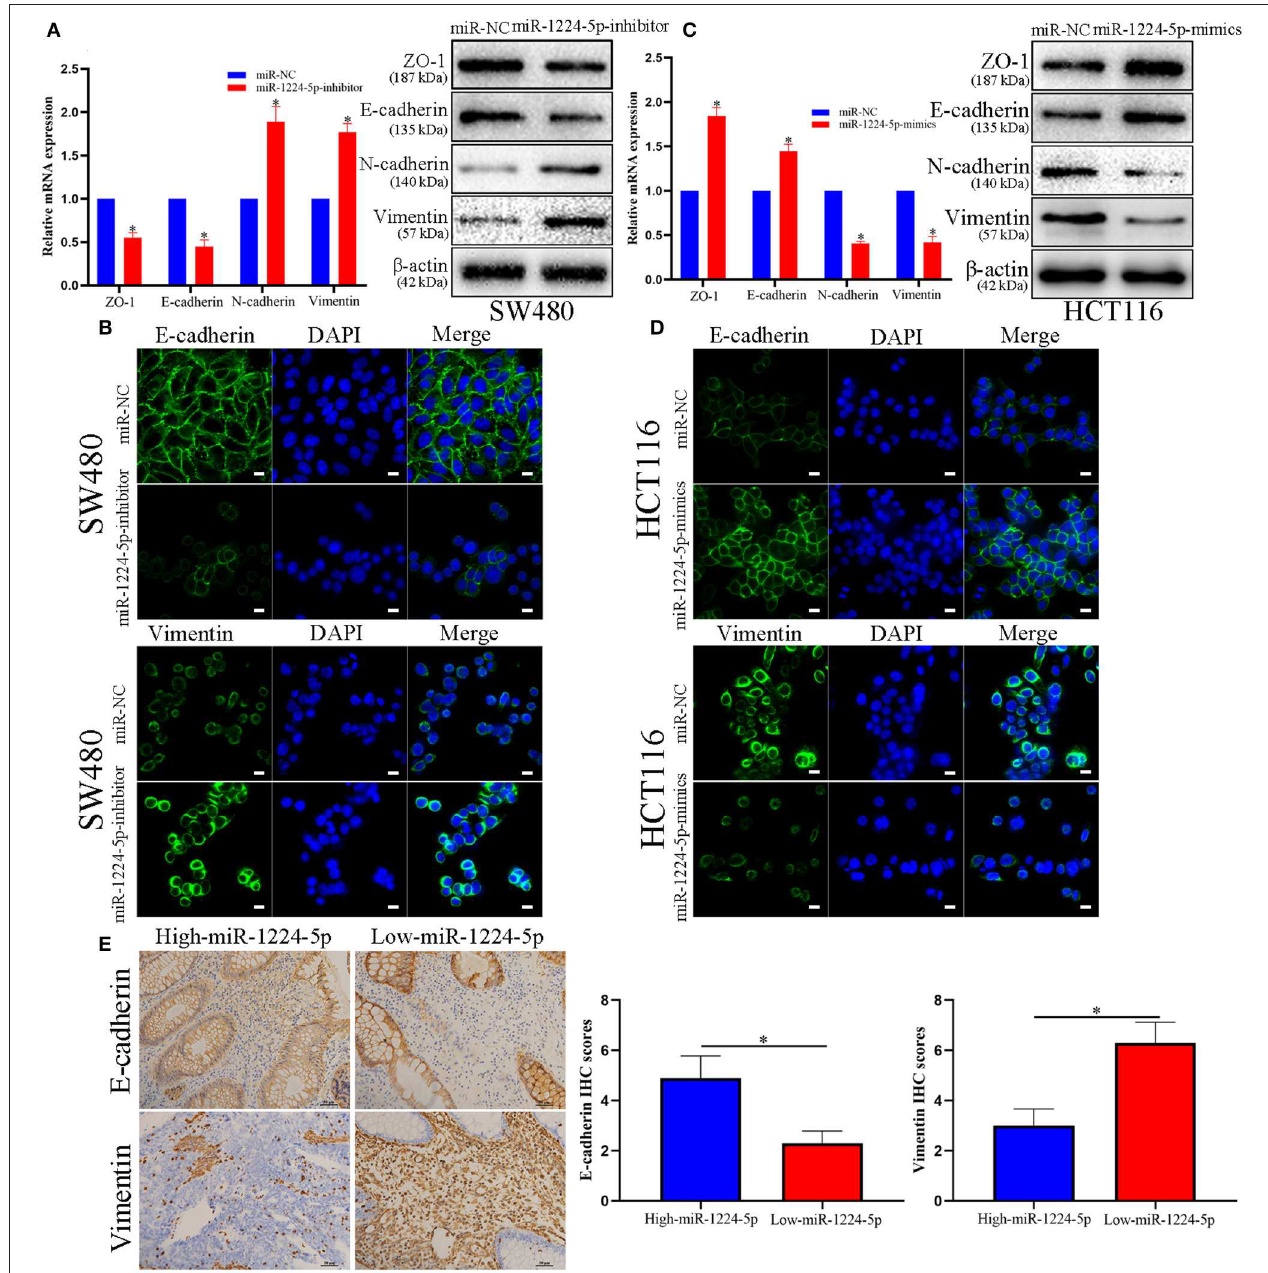
FIGURE 3 | miR-1224-5p inhibits the EMT process of CRC cells. (A) Western blot analysis of tight junction protein ZO-1, epithelial marker E-cadherin, and mesenchymal markers N-cadherin and Vimentin after miR-1224-5p knockdown in SW480 cells. (B) IF staining of E-cadherin and Vimentin after miR-1224-5p knockdown in SW480 cells, scale bars: 10 µ m. (C) miR-1224-5p overexpression increased ZO-1 and E-cadherin expression, and decreased the levels of N-cadherin and Vimentin in HCT116 cells. (D) IF staining of E-cadherin and Vimentin after miR-1224-5p overexpression in HCT116 cells, scale bars: 10 µ m. (E) Immunohistochemistry of E-cadherin and Vimentin were detected and compared between miR-1224-5p high expressing CRC tissues and miR-1224-5p low expressing cases. Data represent the mean ± SD from three independent experiments. Student’s t -test was used to determine statistical significance: * p < 0.05.